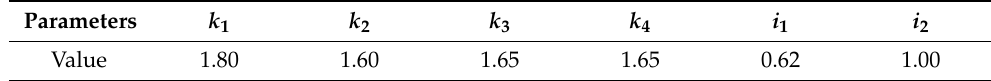
Table 3. Transmission element parameters.